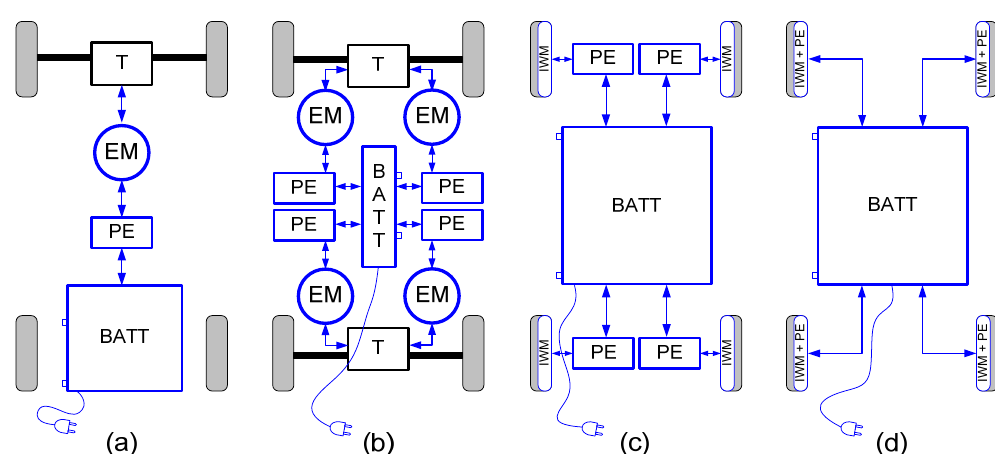
Figure 1. Examples of configurations of the electric drive systems of delivery vehicles ( a ) central driveline with one electric motor, ( b ) power train with four electric motors installed on board the vehicle, ( c ) a driveline with four electric motors installed in the wheels of the vehicle and inverters on board the vehicle, ( d ) drive system with four electric motors and inverters installed in the wheels of the vehicle, where: BATT—Battery Pack; PE—Power Electronics (Inverter); EM—Electric Motor, T—transmission.